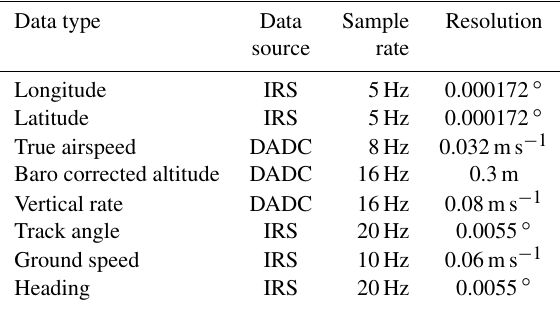
Figure 1. Tracks of DELICAT flights FL6, FL8 and FL9 (black solid lines). Peak turbulent events (red markers and red caption). KNMI data (blue dots) and KNMI data range (light blue shape).